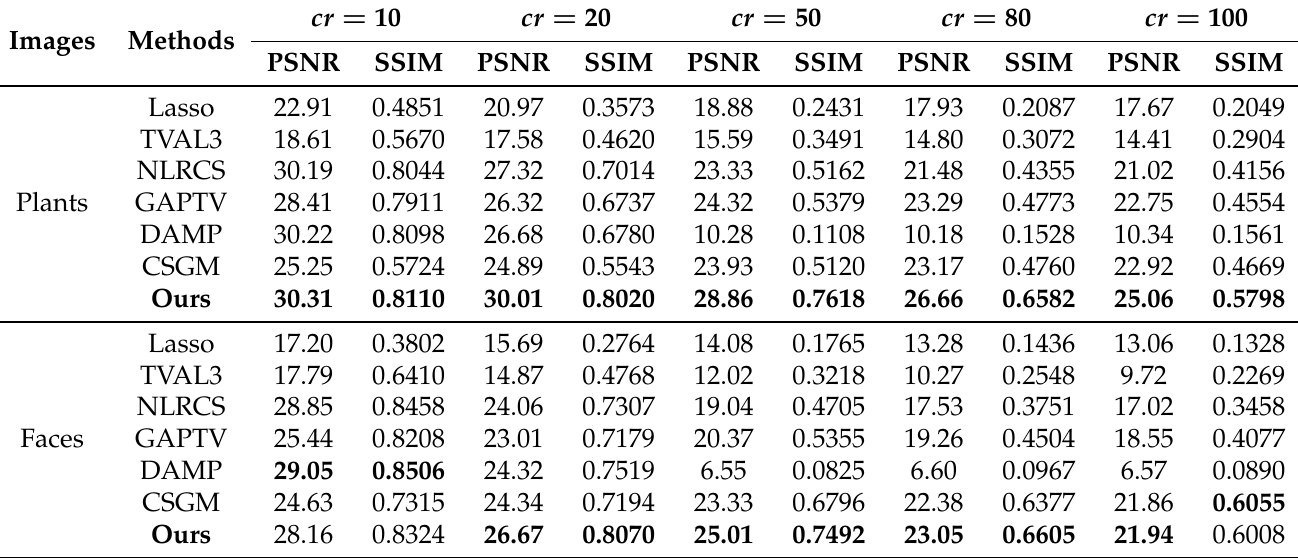
Table 1. Average PSNR and SSIM comparisons of different image CS approaches. Bold indicates the best result.